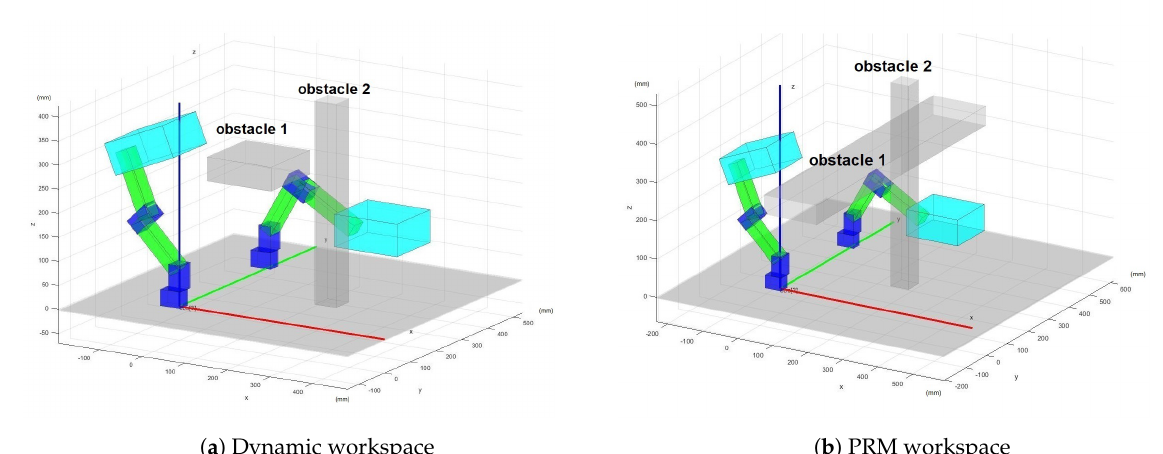
Figure 6. The Matlab workspace.